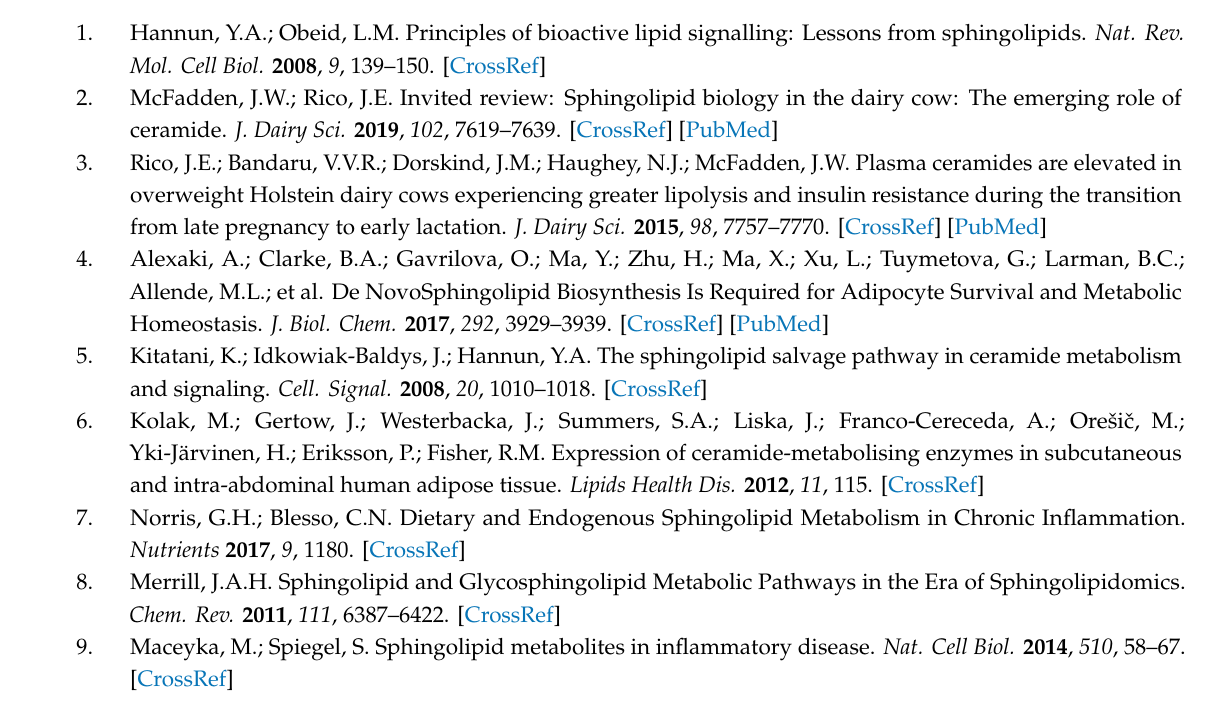
Supplementary Materials: The following figure and table are available online at http: // www.mdpi.com / 2218- 1989 / 10 / 11 / 473 / s1: Figure S1. Principal component analysis (PCA) biplot visualizing the relationship of tissue samples (black) and sphingolipids (red); Table S1. The sphingolipid concentrations (raw data) of bovine SCAT and